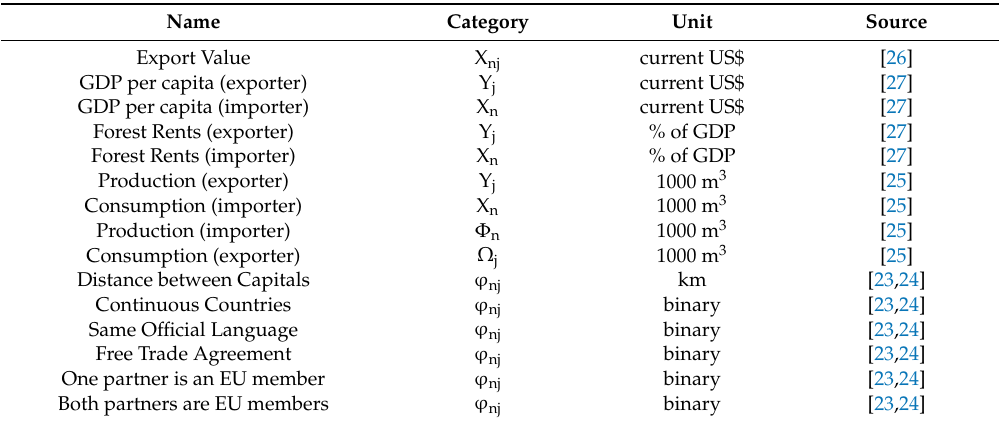
Table 1. Determinants of global wood market